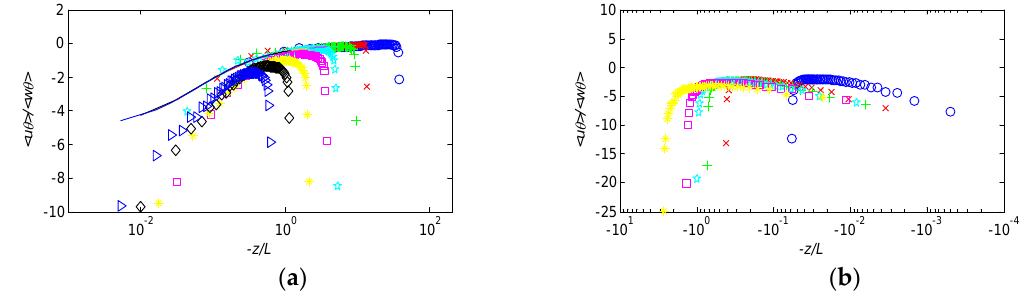
Figure 1. Ratio of horizontal and vertical heat fluxes u (cid:48) θ (cid:48) / w (cid:48) θ (cid:48) versus − z / L . In ( a ), for unstable conditions, the blue circles, red crosses, green plus signs, cyan stars, magenta squares, yellow asterisks, black diamonds and blue rightward-pointing triangles represent cases 17, 16, 15, 14, 13, 12, 11 and 10, respectively, from very to slightly unstable. The curve corresponds to Equation (7). In ( b ), for stable conditions, the blue circles, red crosses, green plus signs, cyan stars, magenta squares, yellow asterisks, black diamonds and blue rightward-pointing triangles represents cases 8, 7, 6, 5, 4, 3, 2, and 1, respectively, going from slightly to very stable.